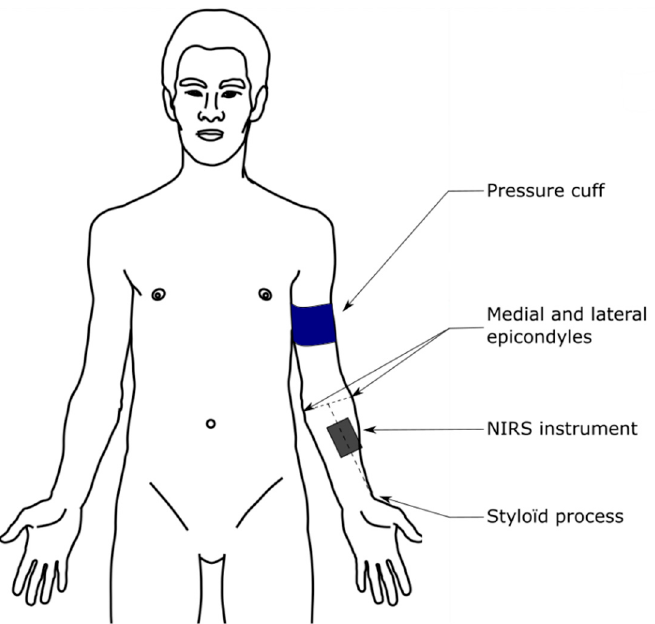
Figure 2. NIRS device placement illustration.